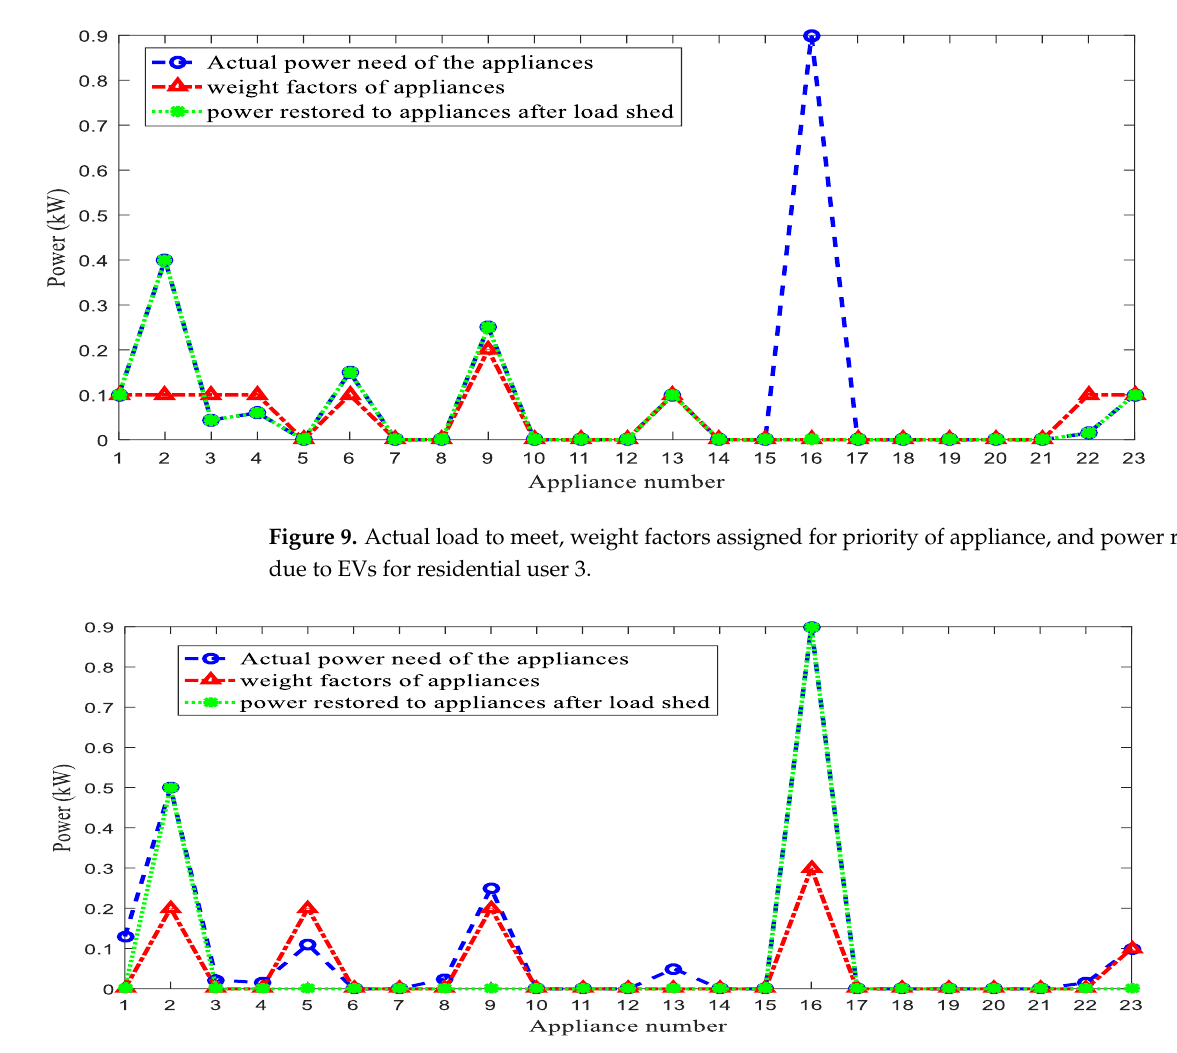
Figure 8. Actual load to meet, factors assigned for priority of appliance, and power restored due to EVs for residential user 2.